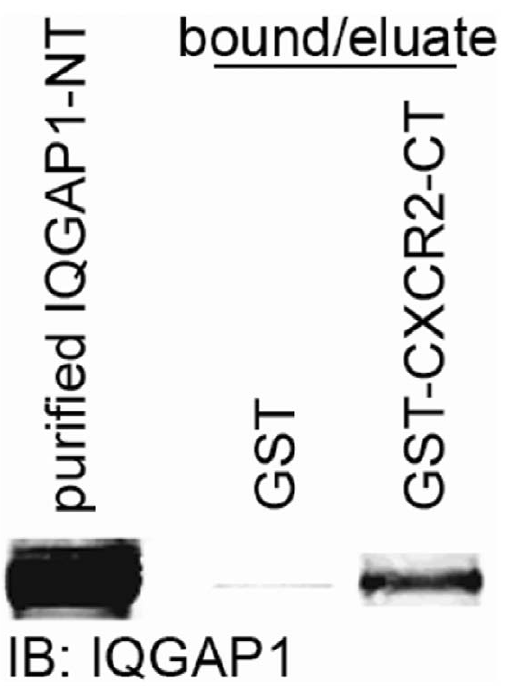
Figure 4. Purified IQGAP1/N-terminus binds directly to GST CXCR2/C-terminus. Western blot analysis of purified IQGAP1/N- terminus (NT) and purified protein bound to glutathione Sepharose beads with GST alone or GST-CXCR2/C-terminus (CT). Briefly, fusion protein-bound glutathione beads were blocked with 1% BSA for 1 h at room temp and incubated for 1 h at 4 u C with 10 m g purified IQGAP1/N- terminus in binding buffer. Beads were washed 3X with binding buffer and bound protein eluted and analyzed by SDS-PAGE and western blot (IB) for IQGAP1. Data shown are representative of three separate experiments.